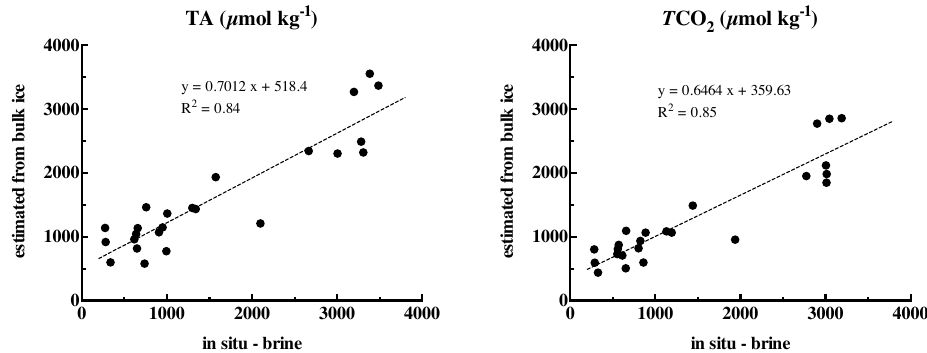
Figure 8. Comparison between brine TA and T CO 2 measured in brine collected using the sackholes technique and the brine TA and T CO 2 estimated from TA ice , TCO 2ice and the brine volume.